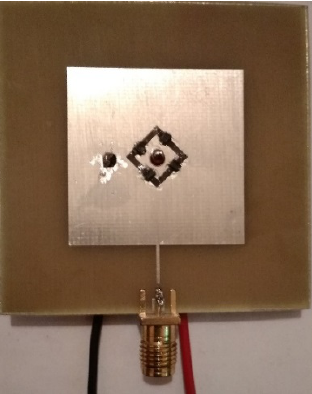
Figure 5(a): Fabricated